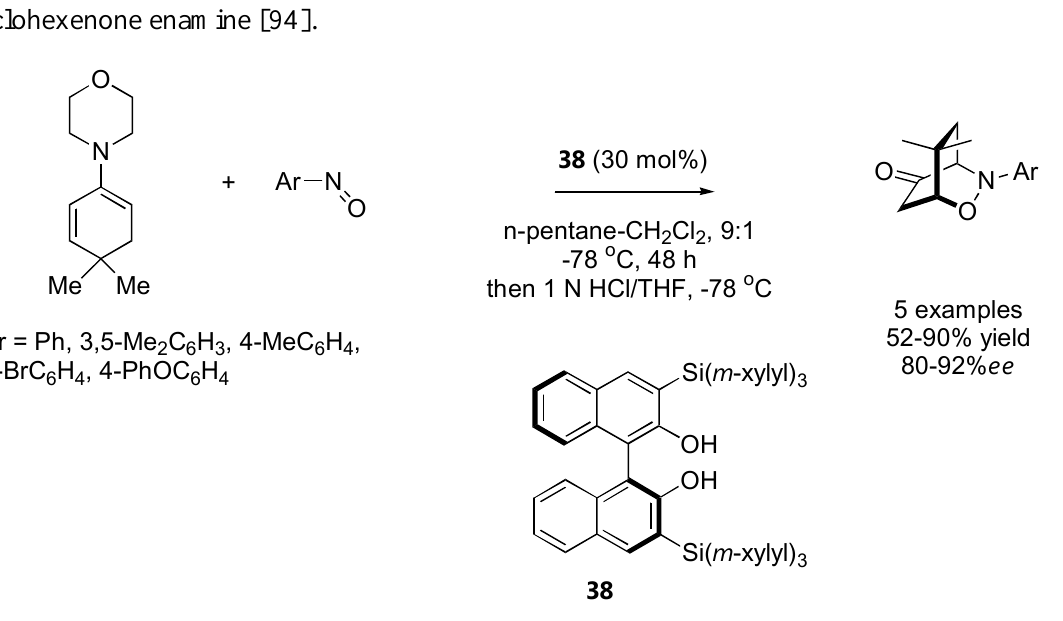
Figure 29. Nitrosoaldol reaction of  -aryl substituted cyanoacetate esters